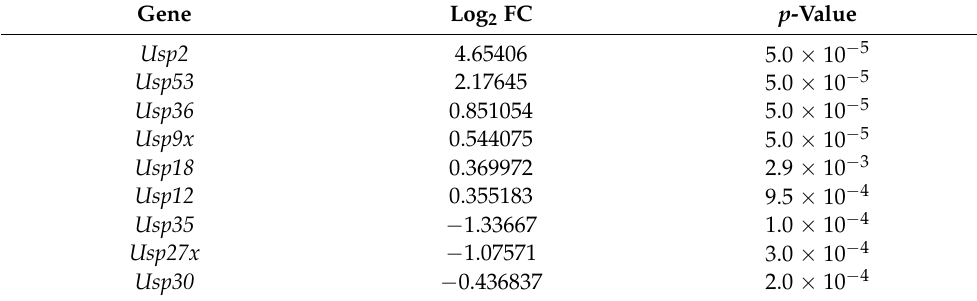
Table 1. Differential regulation of Usp genes by PTH (1–34) treatment in MC3T3-E1 cells. RNA-seq analysis of differentially regulated genes following PTH (1–34) treatment in MC3T3-E1 osteoblast cells. A cutoff of 1 in logscale was used to filter regulated genes by a two-fold change with 95% confidence by a moderated t -test ( p <